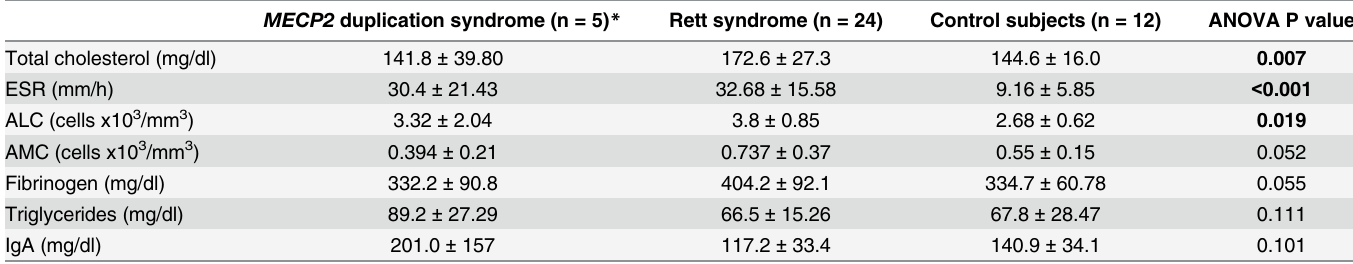
Table 2. Routine chemistry biomarkers in patients with MECP2 duplication syndrome, Rett syndrome, and control subjects. MECP2 duplication syndrome (n = 5)